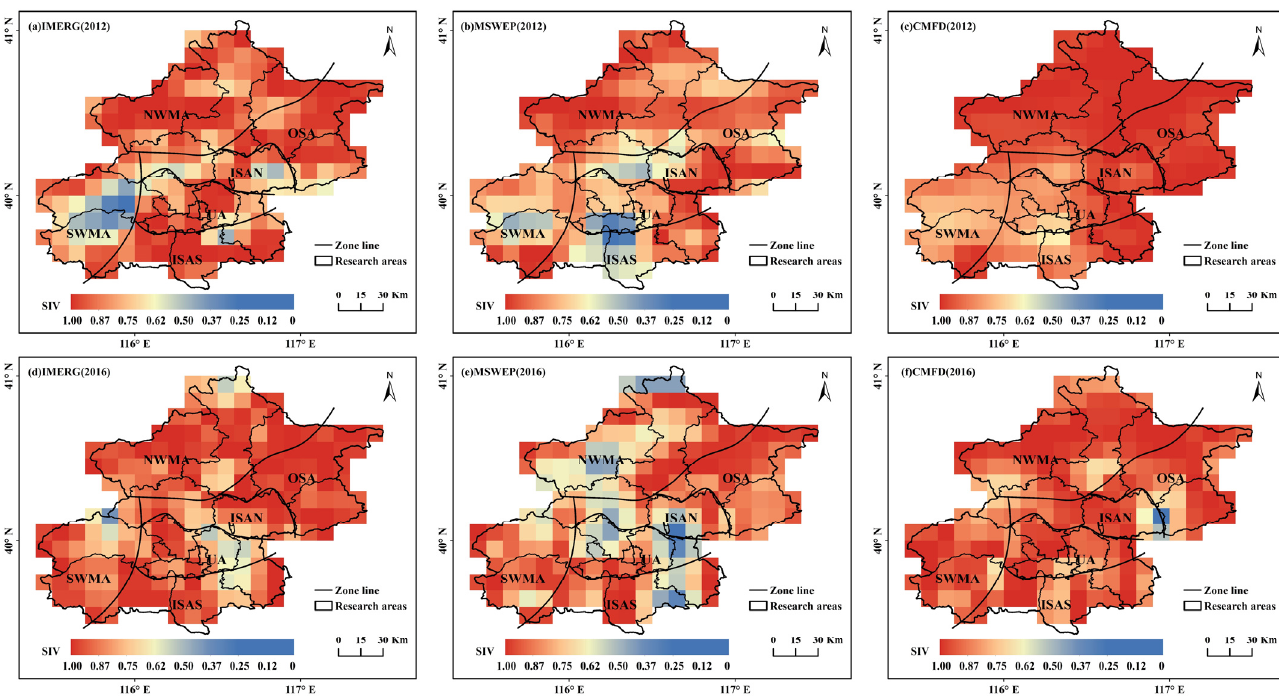
Figure 8. Similarity in variance index (SIV) of the extreme rainstorms that occurred in Beijing on 21 July 2012 and 20 July 2016: ( a ) IMERG (2012), ( b ) MSWEP (2012), ( c ) CMFD (2012), ( d ) IMERG (2016), ( e ) MSWEP (2016), and ( f ) CMFD (2016).